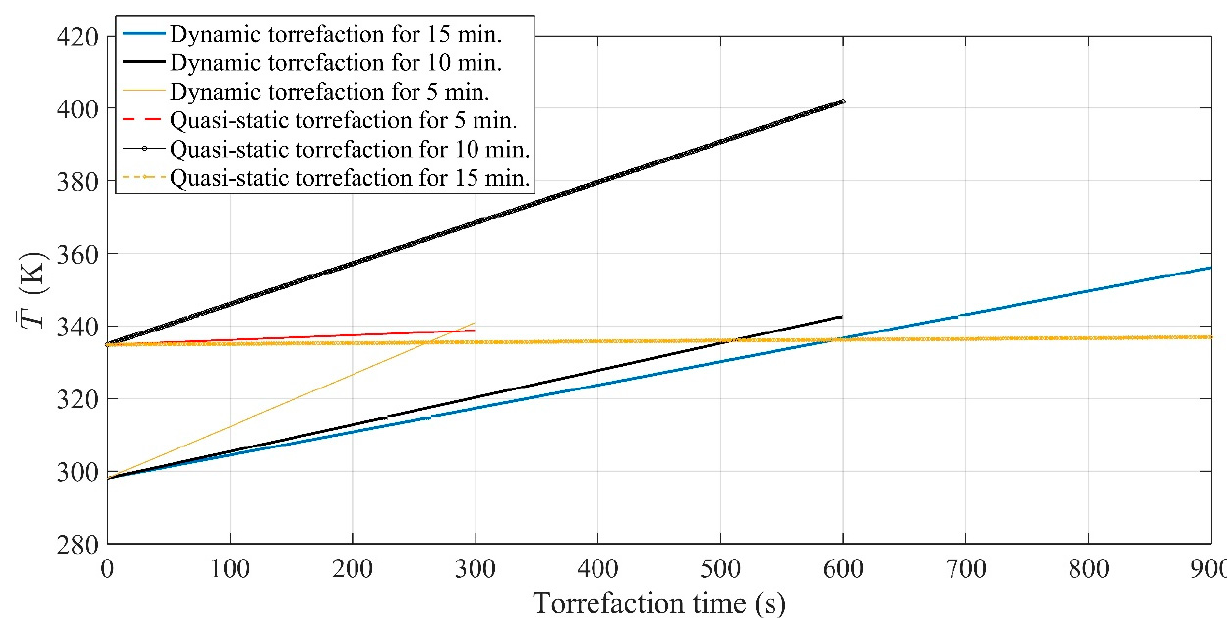
Figure 10. Temperature distribution on the surface of a biofuel pellet in varying heat flux conditions ( a , c , e ): quasi-static, ( b , d , f ): dynamic.